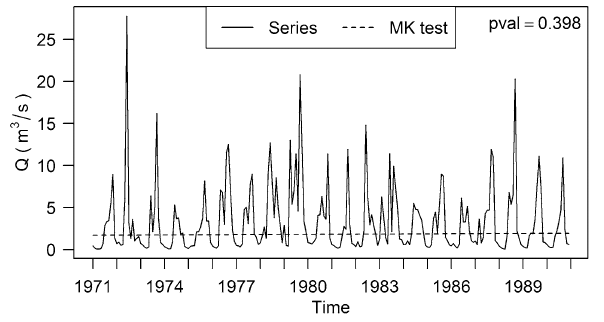
Fig. 2 Mean monthly flow observations measured at the V Aniver- sario outlet from 1971 to 1990